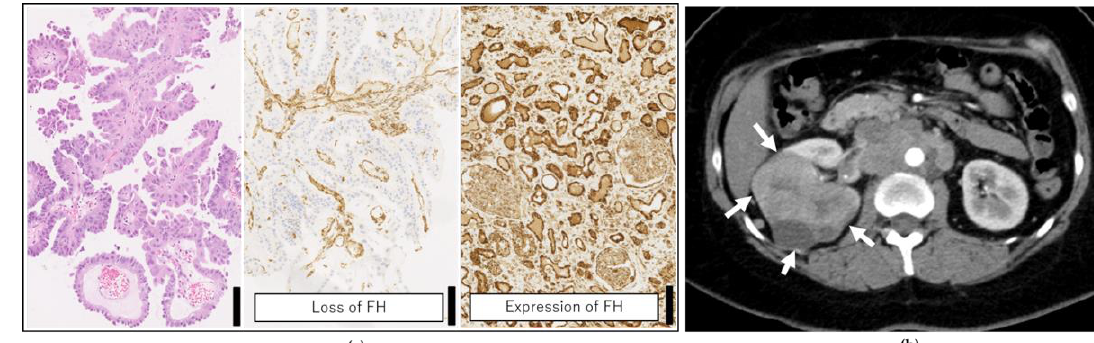
Figure 2. Clinical findings of the patient. ( a ) Histopathological image of the renal biopsy. The left panel shows hematoxylin-eosin staining, and the middle shows immunohistochemical (IHC) staining for FH (loss of which is evident). The right panel is the IHC staining of FH from another patient’s normal kidney as positive staining for FH. Scale bar = 100 μm. ( b ) Contrast computed tomography findings. A large tumor was found in the right kidney (white arrow), and the patient was diagnosed with stage 4 renal cell carcinoma (RCC) as well as multiple metastases in the lung, liver, supraclavicular lymph nodes, para-aortic lymph nodes, adrenal glands, and retroperitoneum.